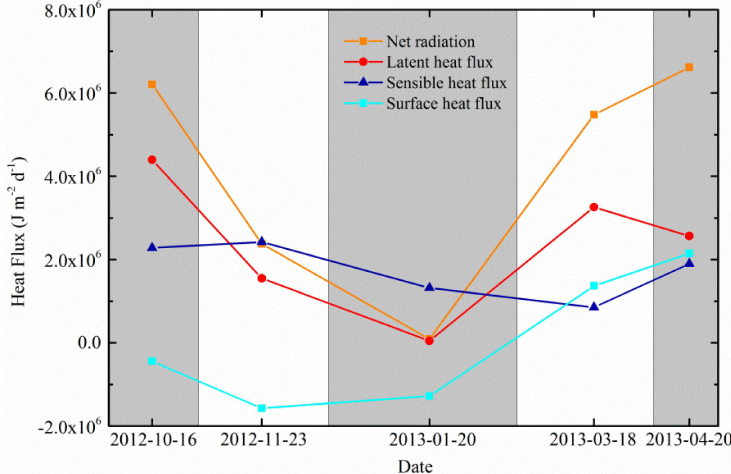
Figure 6. Seasonal energy partitioning during the 2012–2013 winter. The orange, red, blue, and cyan lines with symbols denote net radiation, latent heat, sensible heat, and surface heat flux,